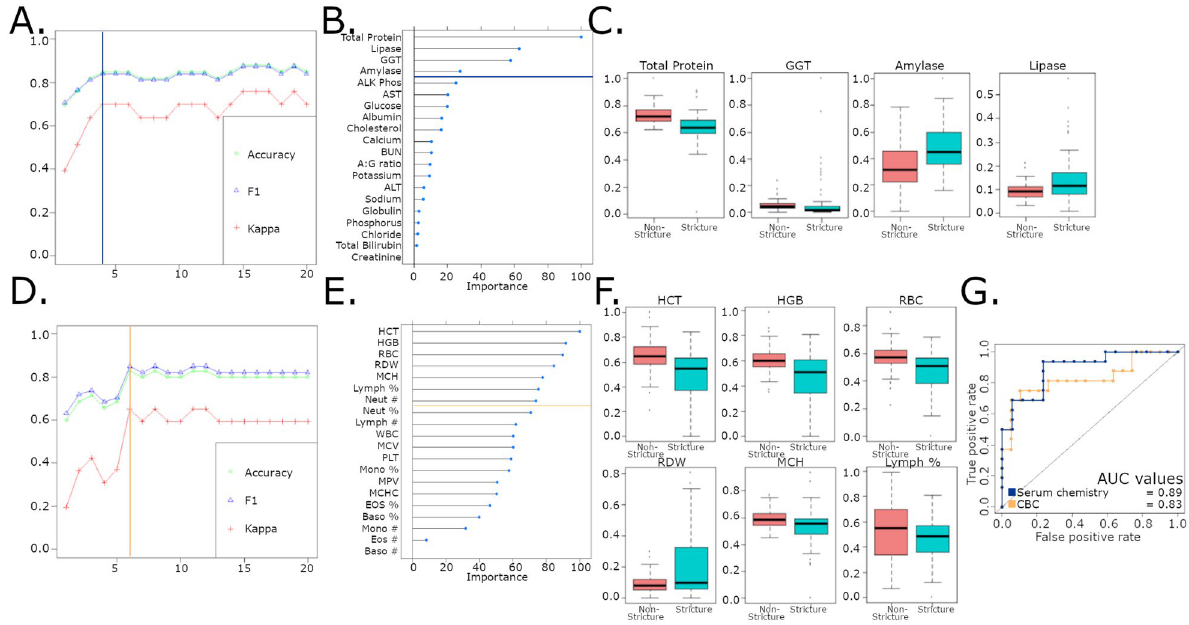
Figure 4. ( A ) Four serum chemistry parameters required for the optimal combination of accuracy and variable number in serum chemistry RF model. ( B ) Variables of importance for RF model using serum chemistry data to classify strictures. ( C ) Four most important parameters include Total Protein, GGT, amylase and lipase. Amylase and lipase are elevated in stricture cases suggesting pancreatic disease. ( D ) Six CBC parameters required for optimal combination of accuracy and variable number in CBC RF model. ( E ) Variables of importance for RF model using complete blood counts (CBC) to classify strictures. ( F ) 6 CBC parameters include HCT, HGB, RBC, RDW, MCH and lymphocyte %. 5 of 6 parameters indicate anemia. ( G ) Area under the curve (AUC) of receiver operating characteristic (ROC) curves for random forest models using serum chemistry (blue) or complete blood (yellow) count show strong performance in classifying strictures and